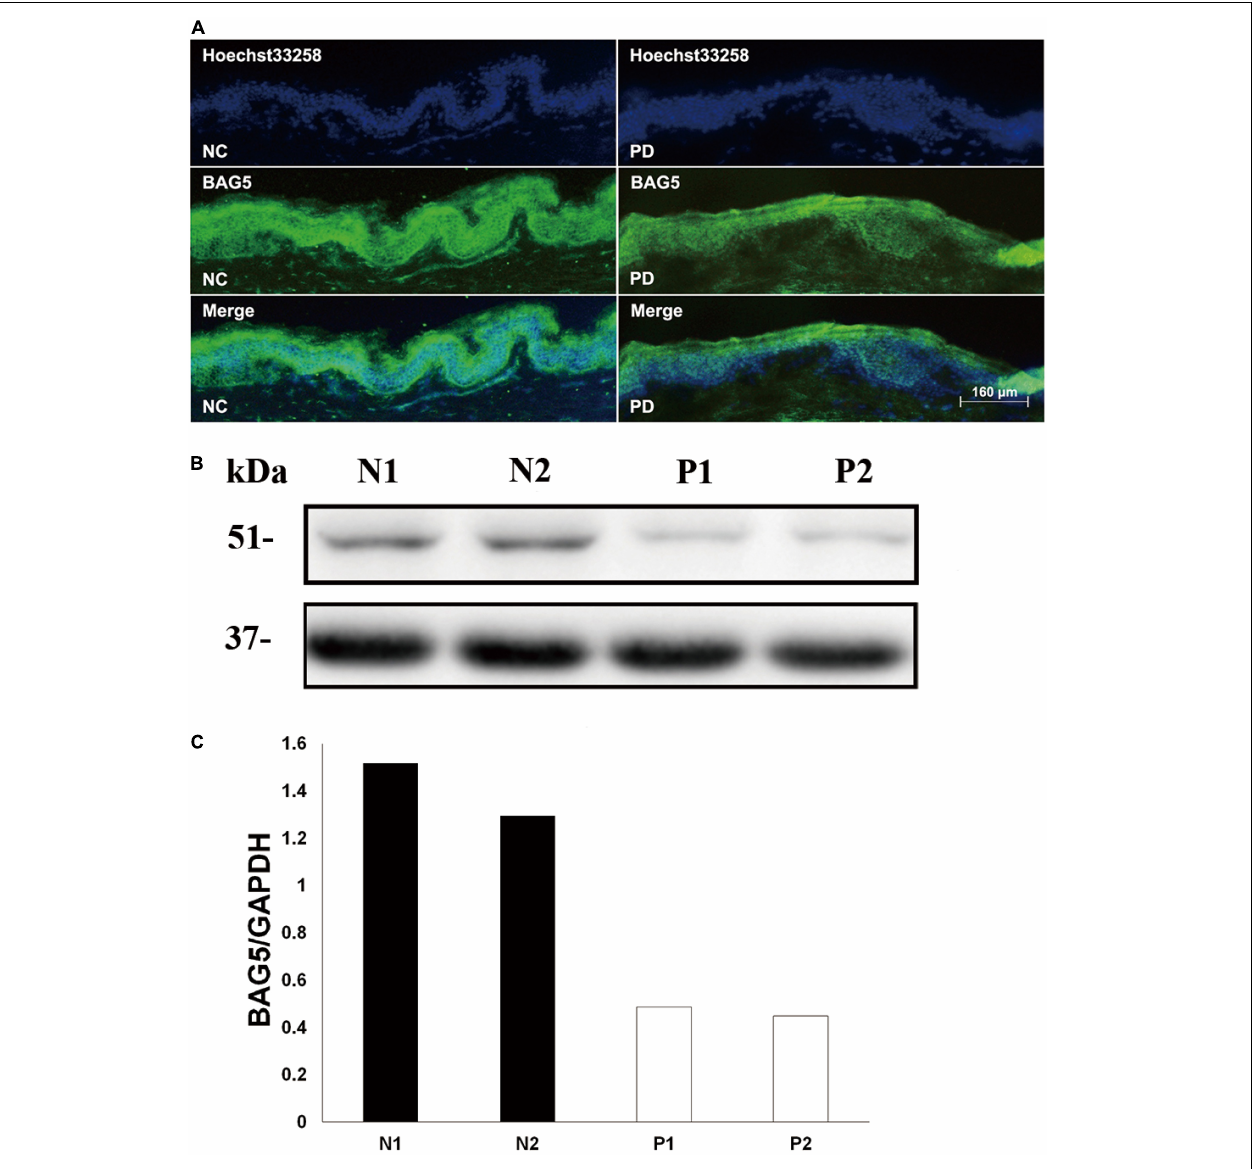
FIGURE 1 | Decreased level of BAG5 in the skin tissue of patients with R492X PINK1 mutation. (A) Immunofluorescence staining for the expression of BAG5 in skin tissues from healthy individuals (NC, left) and patients with PD harboring R492X PINK1 mutation (PD, right). (B) Western blotting was performed using skin tissues from healthy individuals (N1 and N2) and PD patients with R492X PINK1 mutation (P1 and P2). (C) Quantitative data from (B) (Density of endogenous BAG5 against GAPDH) using NIH ImageJ. The data represent the intensity of BAG5 band of the healthy individuals (N1 and N2) or PD patients with R492X PINK1 mutation (P1 and P2), respectively. GAPDH serves as a loading